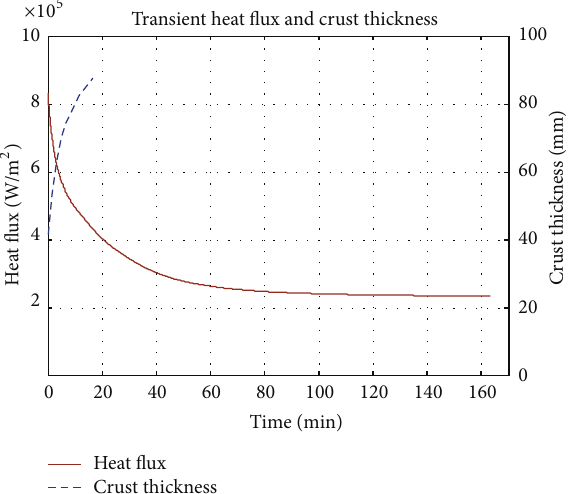
Figure 21: Transient crust thickness and heat flux to the CRGT section submerged in the metal